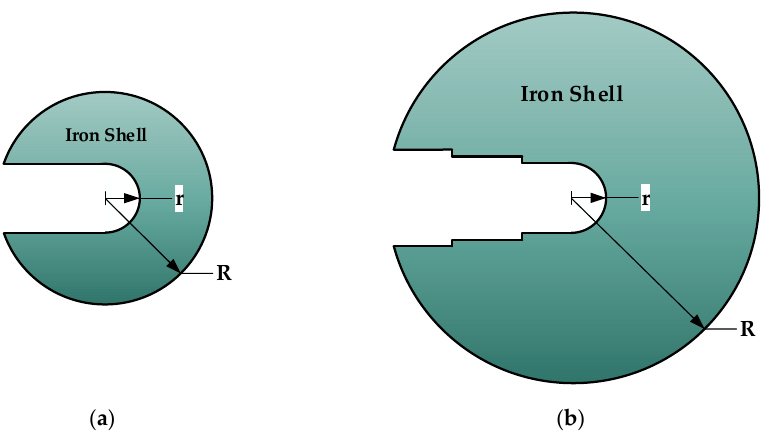
Figure 5. Geometry of ippe_fe iron sphere benchmark of shells and reentrant holes with various radii. ( a ) Simpli fi ed geometry of experimental device Shell 1, r = 2.0 cm, R = 4.5 cm. ( b ) Simpli fi ed geometry of experimental devices Shell 2 to 5, r = 4.5, 2.0, 1.9, and 2.0 cm, R = 12.0, 12.0, 20.0, and 30.0 cm, respectively.